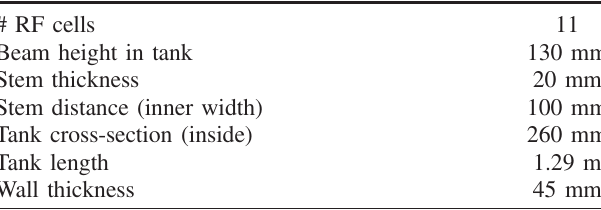
TABLE II. Geometric Parameter of the 4-Rod RFQ for FNAL.